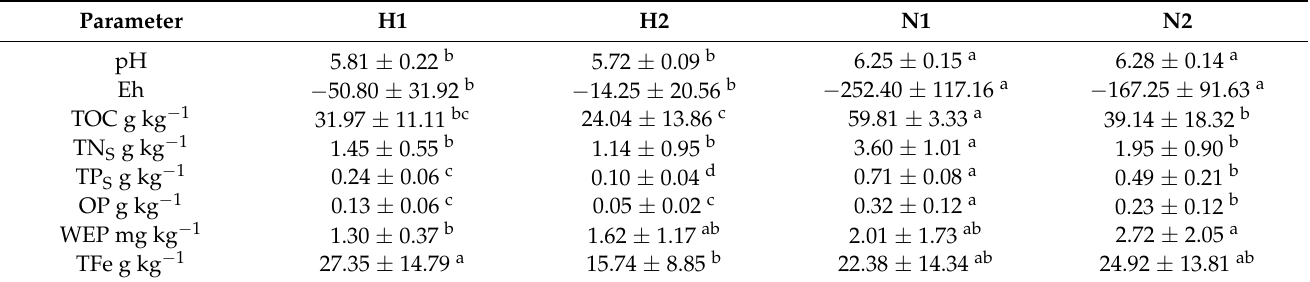
Table 1. Physiochemical properties of sediments at each sampling site (H1, H2, N1, and N2). Values are mean ± standard deviation of the layered sediments from the same